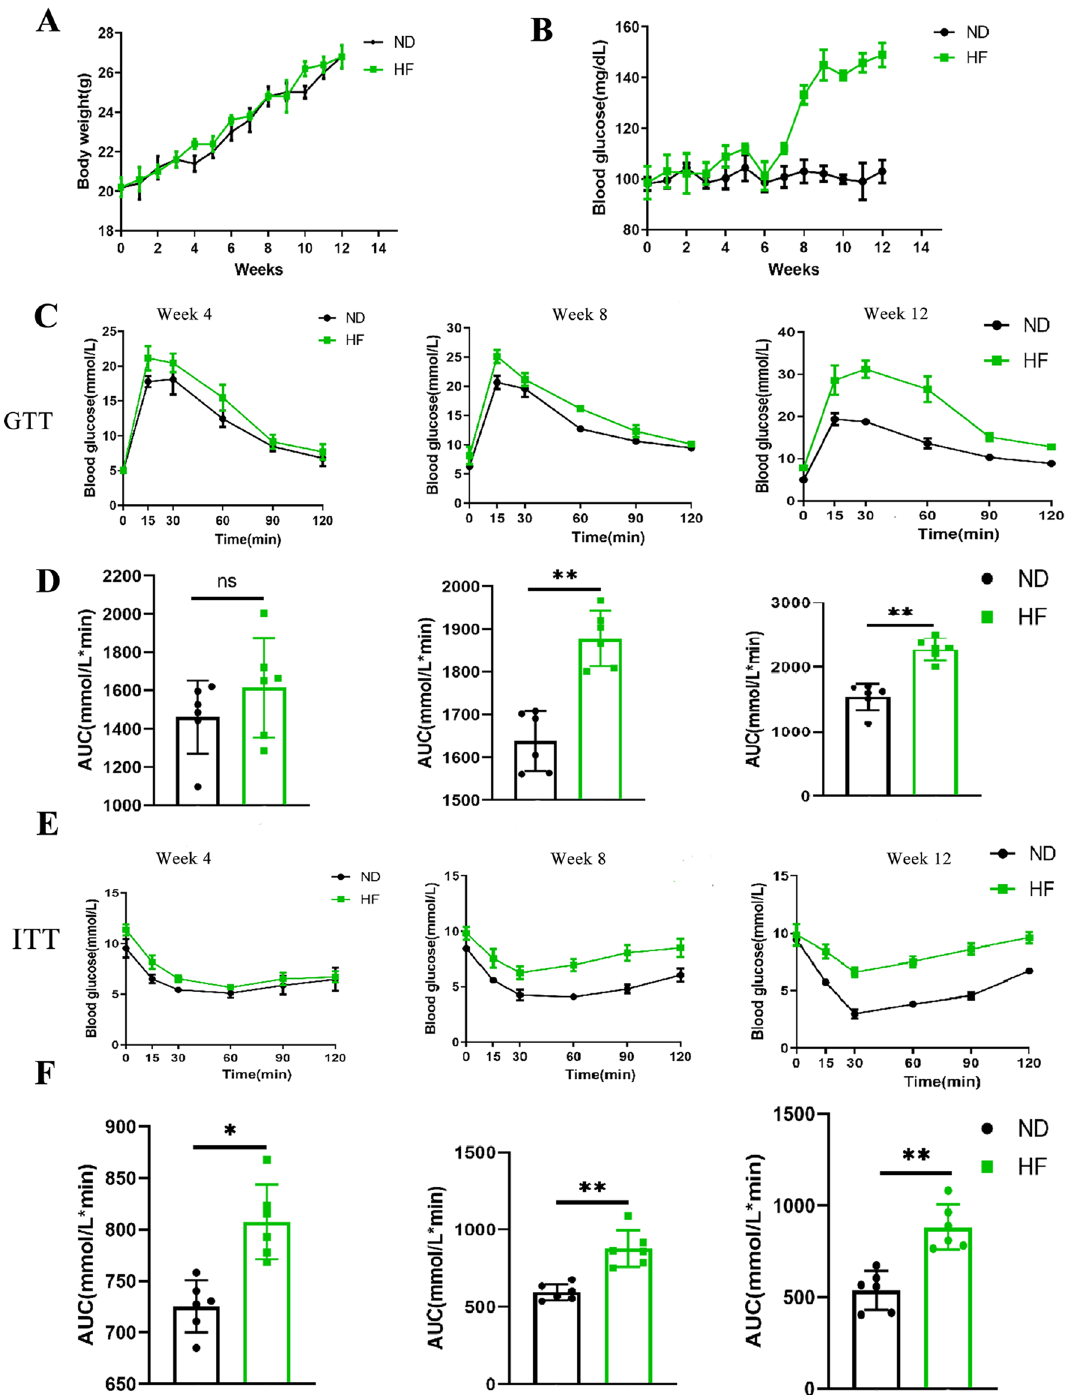
Figure 1. Effects of HF diet on body weight and insulin resistance. ( A ) Weight gain of mice on ND and HF during the 12 weeks of feeding. ( B ) Fasting blood glucose changes during the 12 weeks of feeding. ( C ) Glucose tolerance test, and ( D ) glucose tolerance test calculated AUC measured at 4, 8, and 12 weeks. ( E ) Insulin tolerance test, and ( F ) insulin tolerance test calculated AUC measured at 4, 8, and 12 weeks. The student’s t-test was used to determine statistical significance. * p < 0.05; ** p <